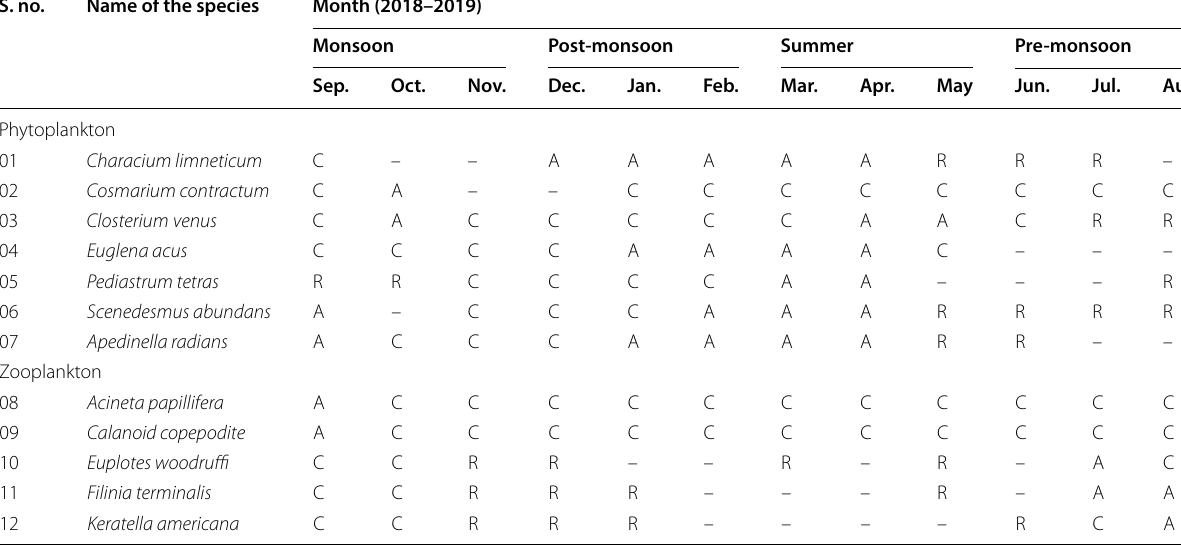
A, Abundance; C, Common; R, Rare; and –, Absent